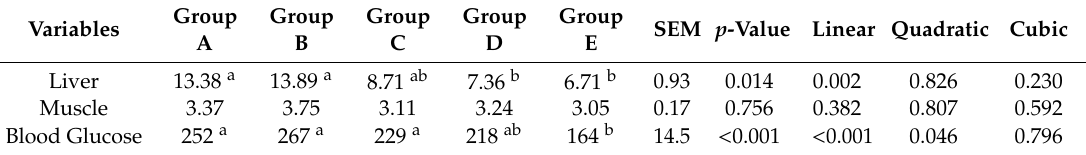
Table 5. E ff ect of Cr-CNPs supplementation on liver and muscle glycogen concentration (mg / 100g) and blood glucose concentration (mg / dL) in Table 5. Effect of Cr-CNPs supplementation on liver and muscle glycogen concentration (mg/100g) and blood glucose concentration (mg/dL) in broilers.